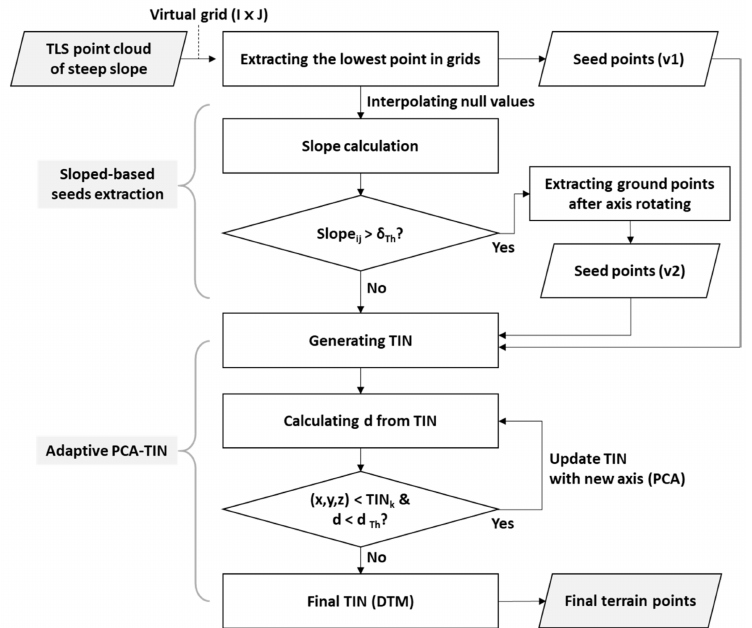
Figure 4. A flowchart of the proposed filtering algorithm (TIN; triangulated irregular network, PCA; principal component analysis, I; the number of rows of virtual grid, J; the number of columns of virtual grid, Slope i , j ; slope angle of ( i,j ) in virtual grid, δ Th ; slope angle threshold, TIN k ; k th triangle, d ; distance between a target point ( x,y,z ) and TIN k , d Th ; threshold value of d